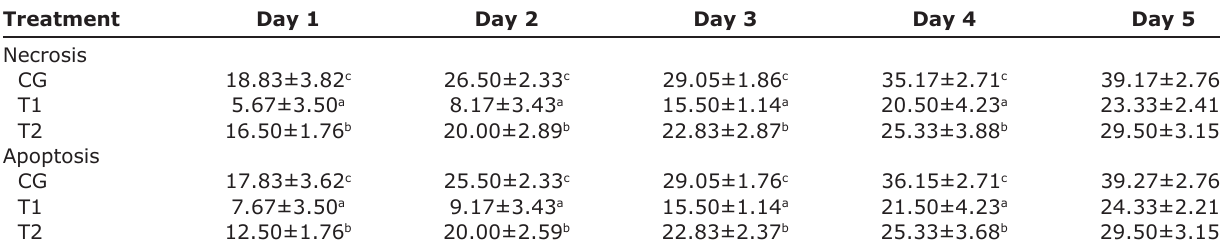
Values with different superscripts in the same column of IPM and MDA variables are significantly different (p<0.05). CG=Control group, T1 and T2 diluted semen supplemented with L-arginine at 4 and 6 mM, respectively, MDA=Malondialdehyde, IPM: Intact plasma membrane Table-5: Effect of L-arginine addition in skim milk extender chilled for a 5-day evaluation on the necrosis and apoptosis (%) of goat spermatozoa.